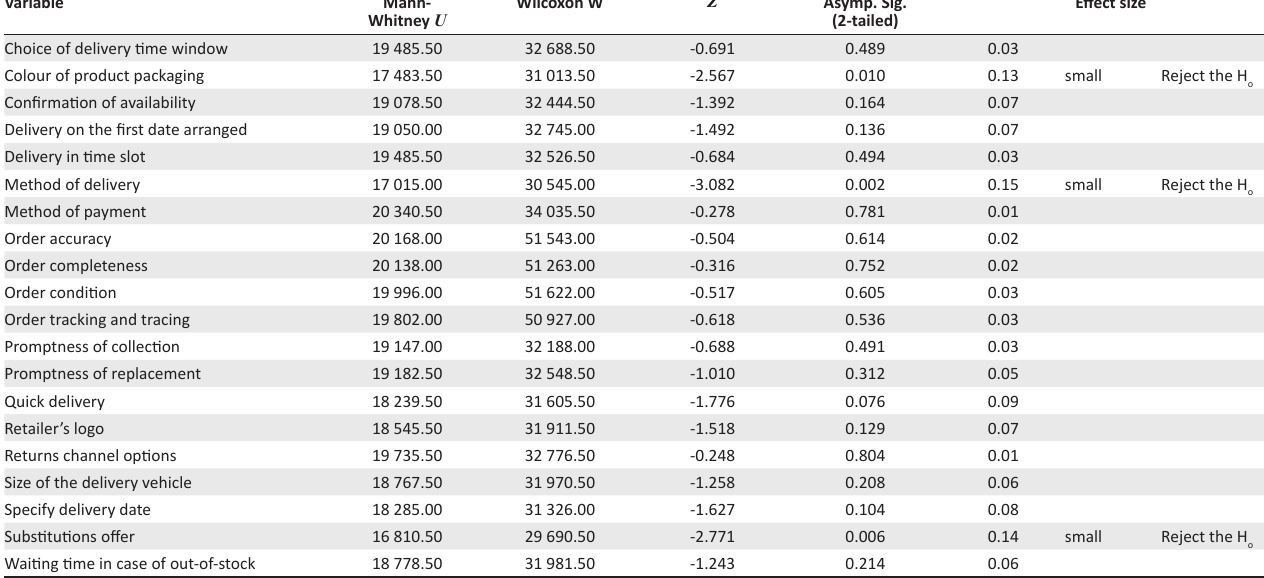
TABLE 5: Statistical differences between perceptions of service quality variables.